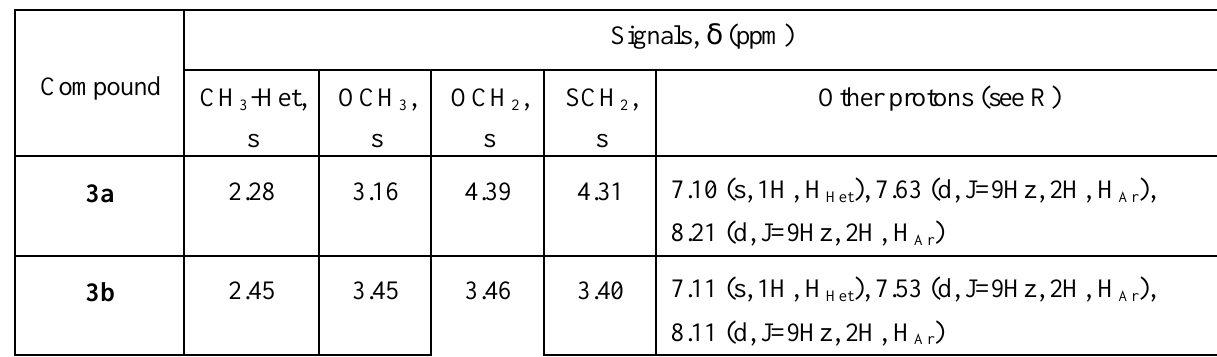
Table 3 – 1 H NMR – spectral